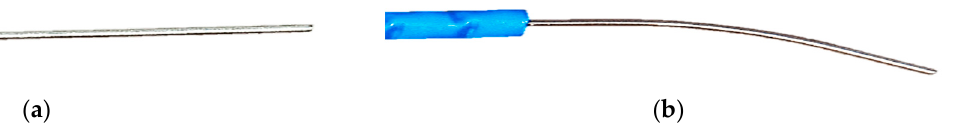
Figure 11. Layered cable with steel strengthening insert: ( a ) before the deformation; ( b ) after the permanent (plastic) deformation.